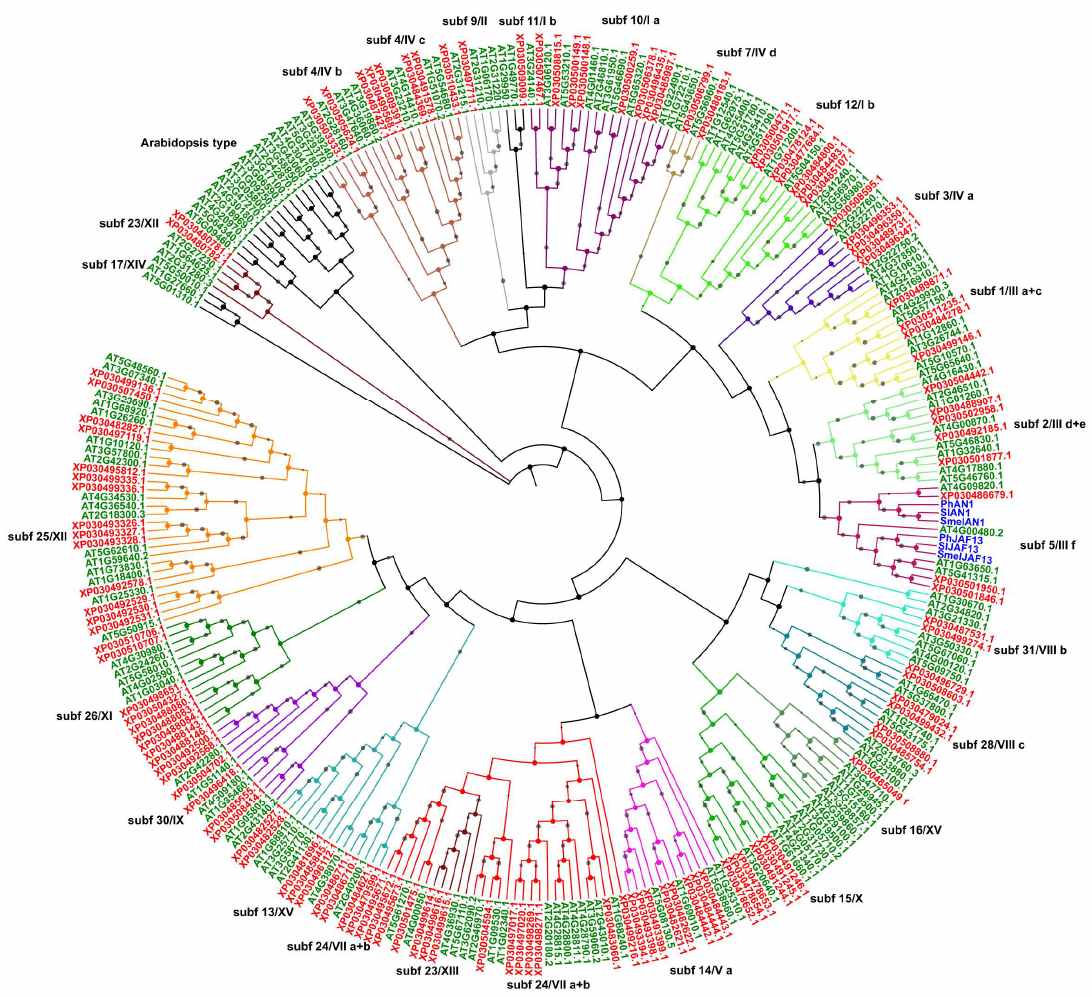
Figure 1. Comparative phylogenetic tree and classification of bHLH proteins in Cannabis sativa and Arabidopsis thaliana . The optimal tree (sum of branch length = 74.12972819) is shown. The tree is drawn to scale, with branches’ lengths in the same units as those of the evolutionary distances used to infer the phylogenetic tree. The percentage of replicate trees in which the associated taxa clustered together in the bootstrap test (1000 replicates) is displayed next to the branches as gray circle with size ranging from 1 to 5. Branches corresponding to partitions reproduced in less than 50% bootstrap replicates are collapsed. The genome-wide analysis involved 294 amino acid sequences divided into 26 phylogenetic subgroups marked with di ff erent clade colors and numbers corresponding to known subfamilies [30,31]. The leaf labels of bHLH members from Arabidopsis , Cannabis , and other species are written in green, red, and blue,